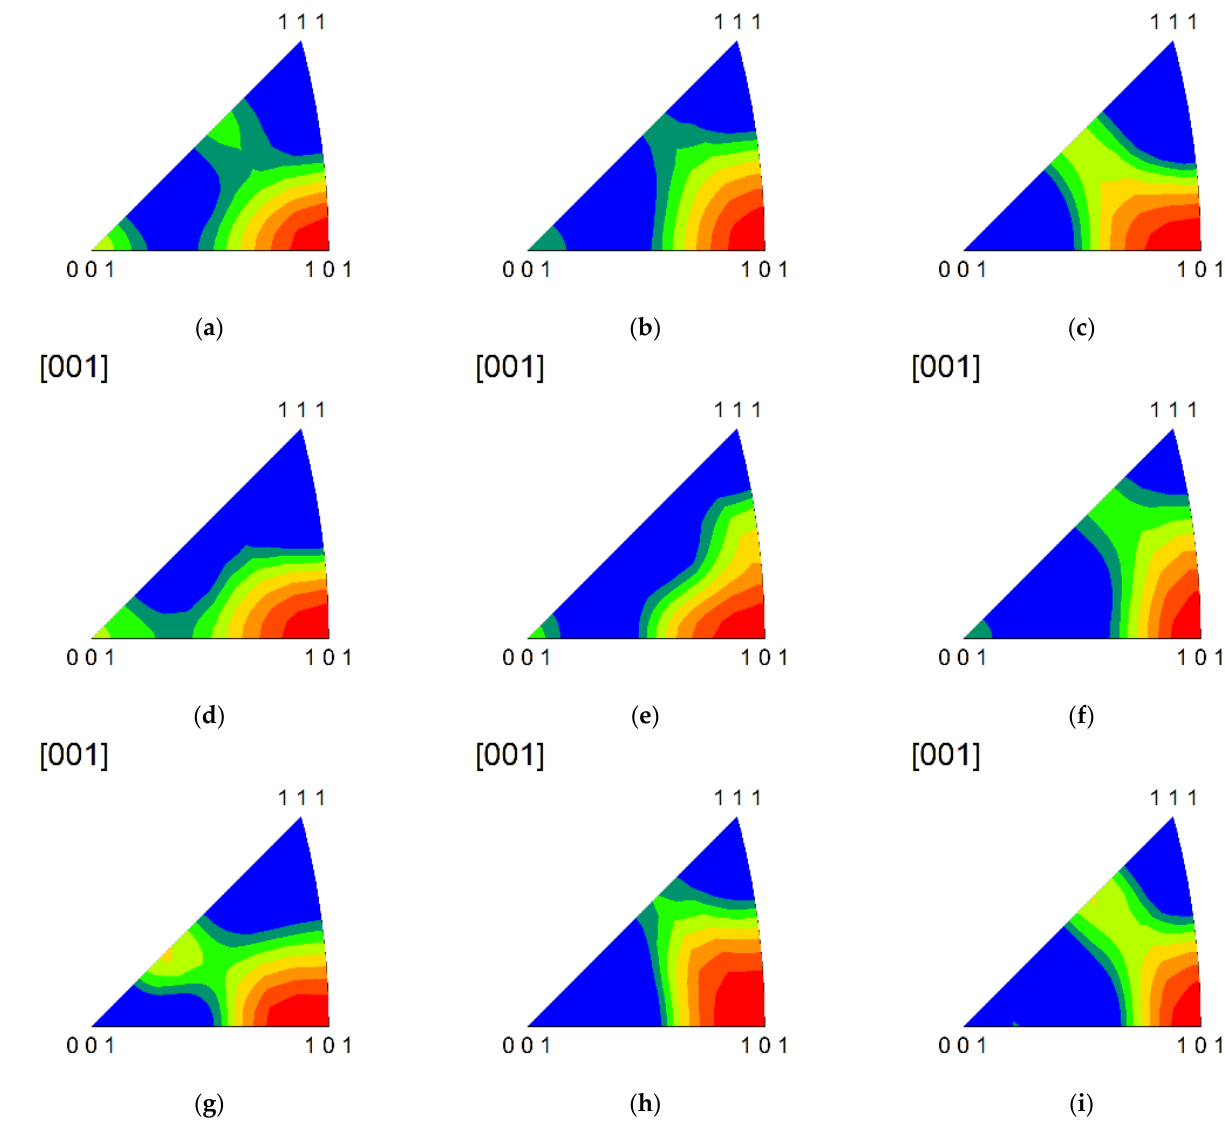
Figure 11. The IPF from the experiment after deformation by hot compression. (The subgraph captions ( a – i ) correspond to the experimental groups (1) to (9) in Table 2, respectively).